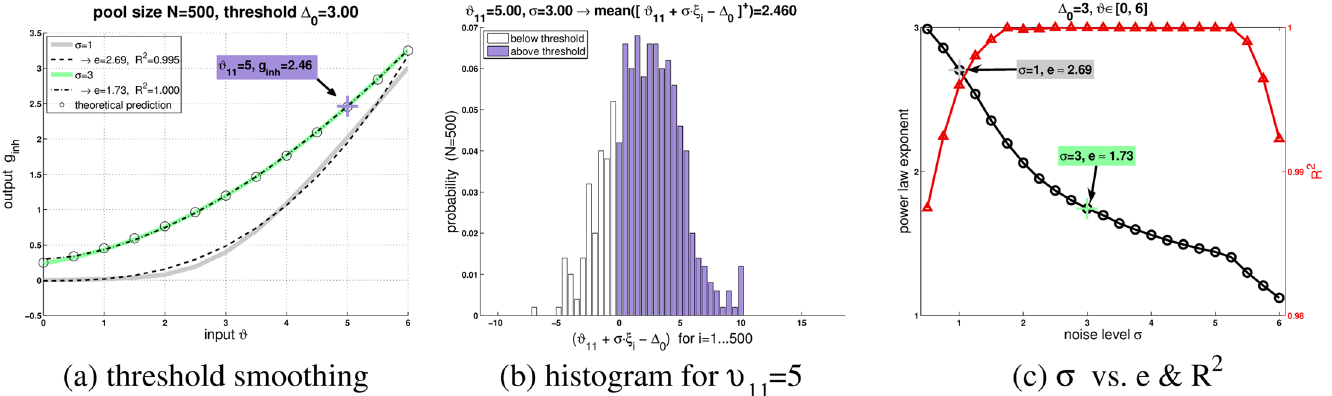
Fig 3. Threshold smoothing and power law (illustration of Eq (14)). ( a )The dependence of g inh on 13 values of W is shown at two different noise levels ( σ = 1 and σ = 3, see legend) along with respective fit of a power law (exponents e = 2.69 and e = 1.73, see legend). For σ = 3, the theoretical prediction is shown as well (circles; cf. Equation A7 in S1 Text) ( b )For W 11 = 5 (eleventh data point), the distribution of W 11 + σ (cid:3) ξ i − Δ 0 is shown from i = 1 to i = N . In order to compute g inh , these values are first half-wave rectified (what zeros the values which correspond to the white bars in the histogram), and subsequently averaged (non-zero contribution from values represented by the colored bars). This eventually yields g inh = 2.46 for W 11 . Thus, non-zero g inh -responses for some W < Δ 0 result from fluctuations with ξ i > 0 such that W + ξ i > Δ 0 . If W is decreased, then whole distribution will shift to the left. ( c ) Power laws were fitted to the g inh versus W curves and exponents e (circles) along with R 2 (triangles) are plotted. These curves are well described by a power law only at intermediate noise levels, here 1.75 (cid:6) σ (cid:6)